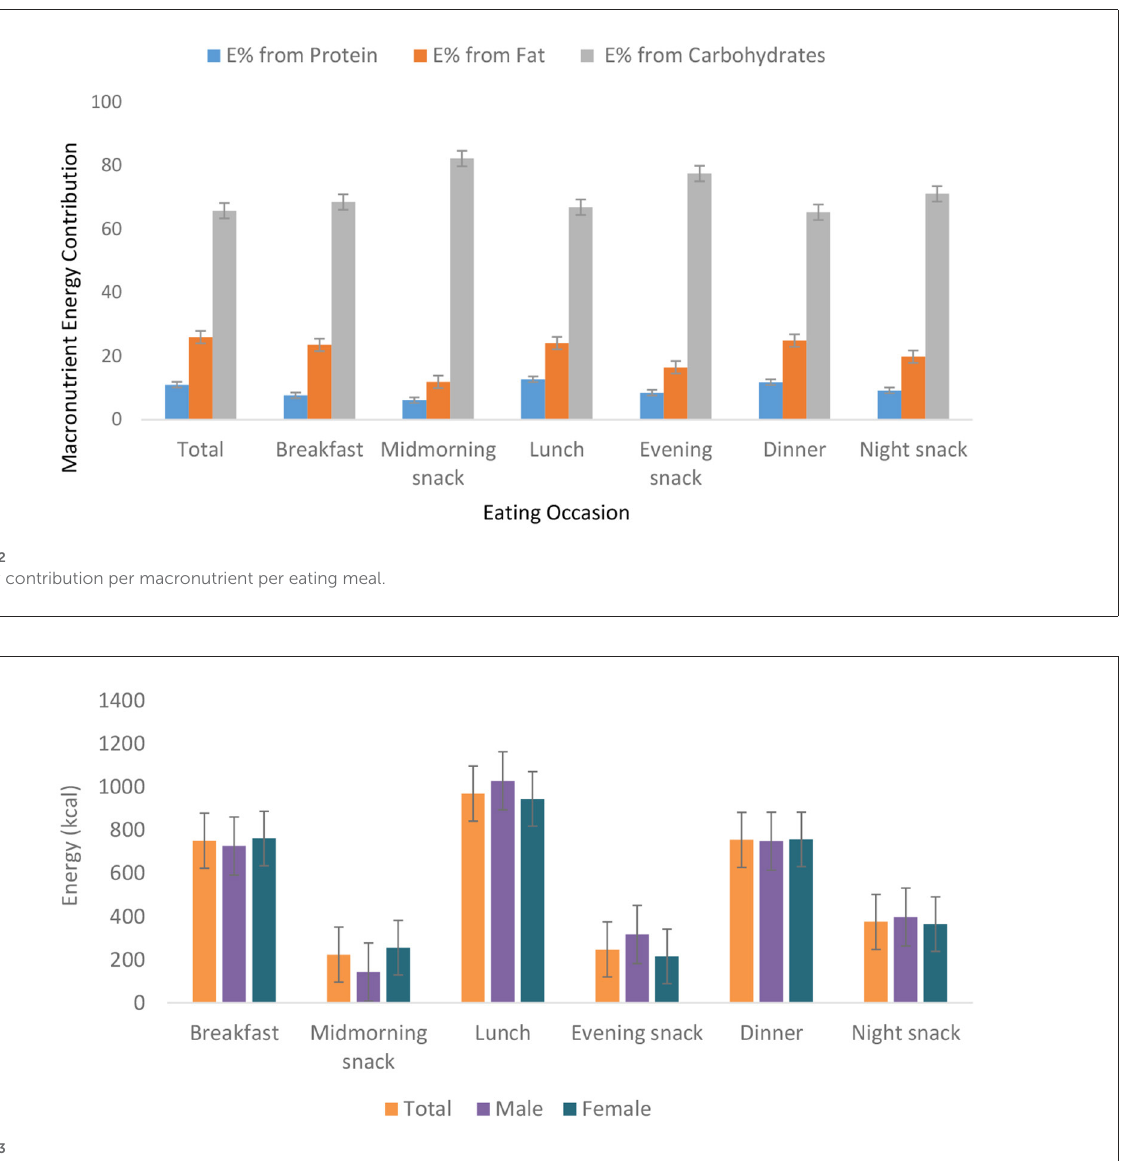
FIGURE3 Energy distribution per eating